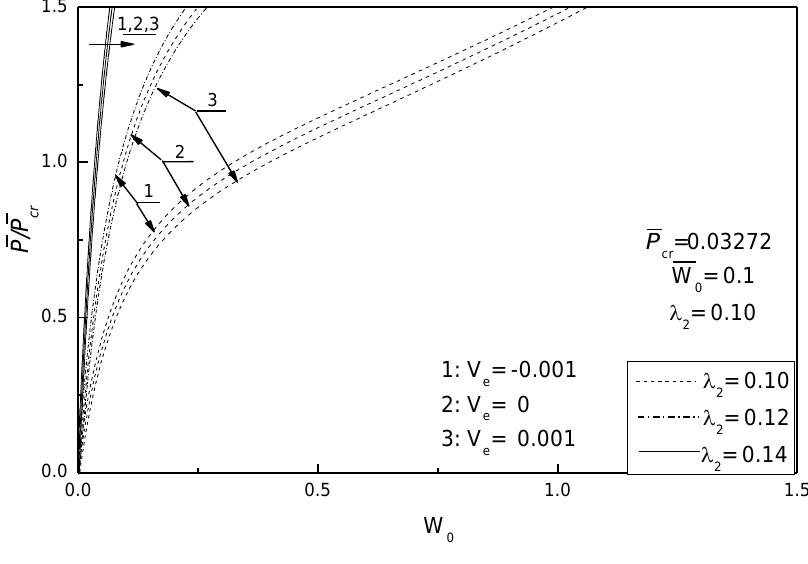
Figure 10. Effect of external loads on postbuckling response curves of piezoelectric plate with damage and initial